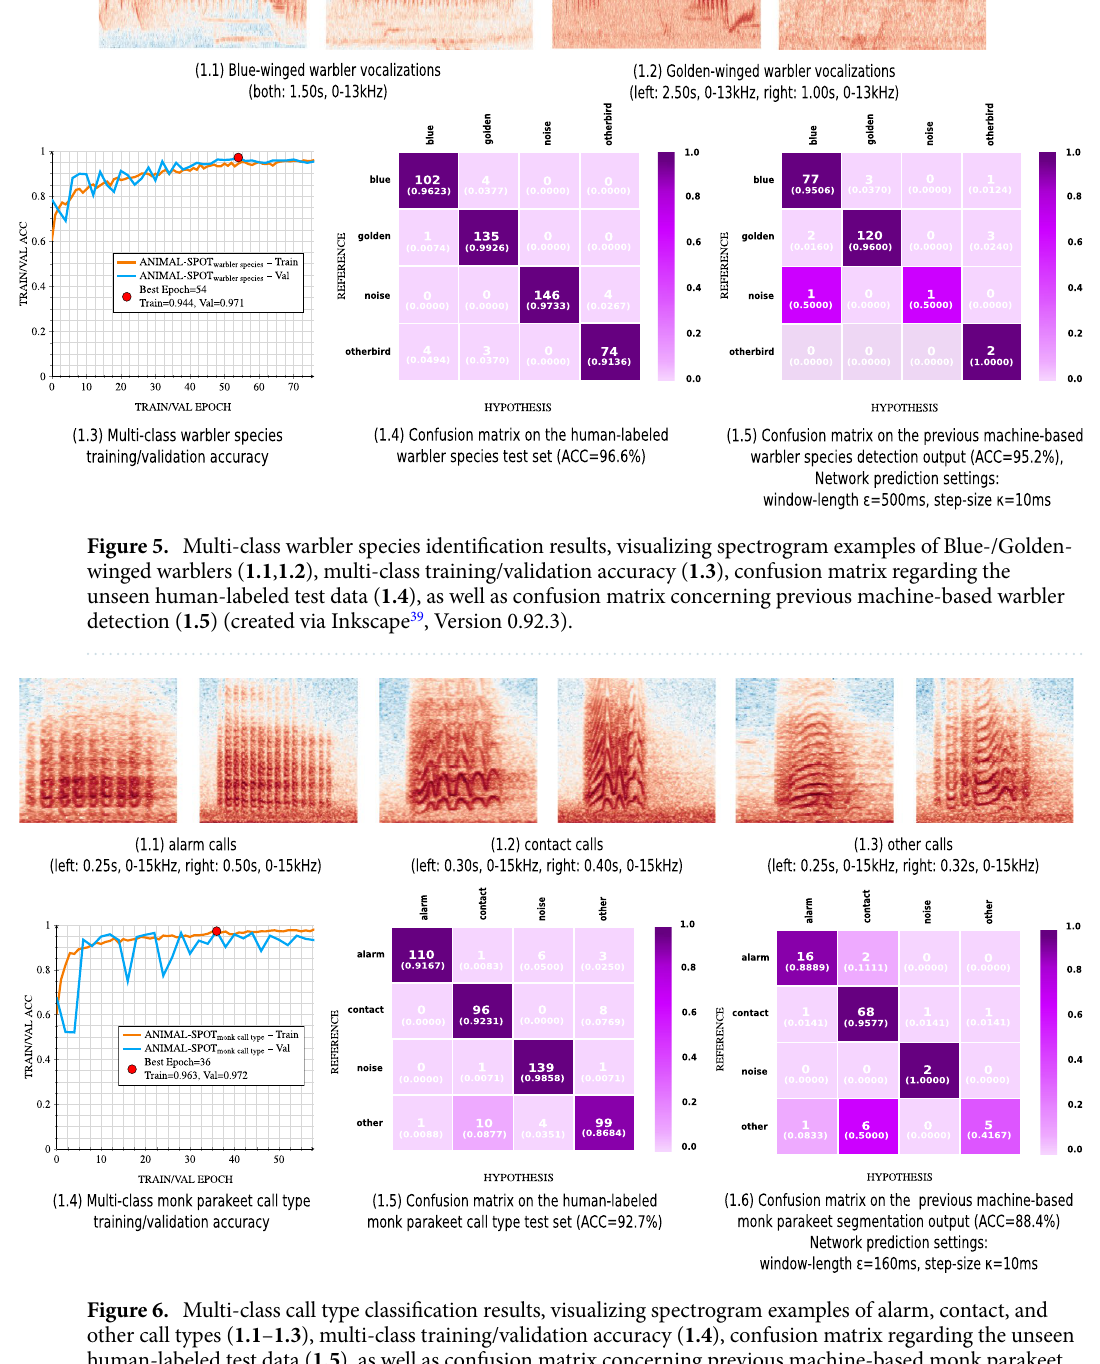
Table 1. For reasons of comparison and the sake of completeness, parts of the already published results on killer whales (see ORCA-SPOT 34 ) are reported and visualized as well. Multi‑class species and call type classification. As baseline for the second experiment, results of the first target/noise (binary) animal-species segmentation were utilized, next to a pure stand-alone multi-species